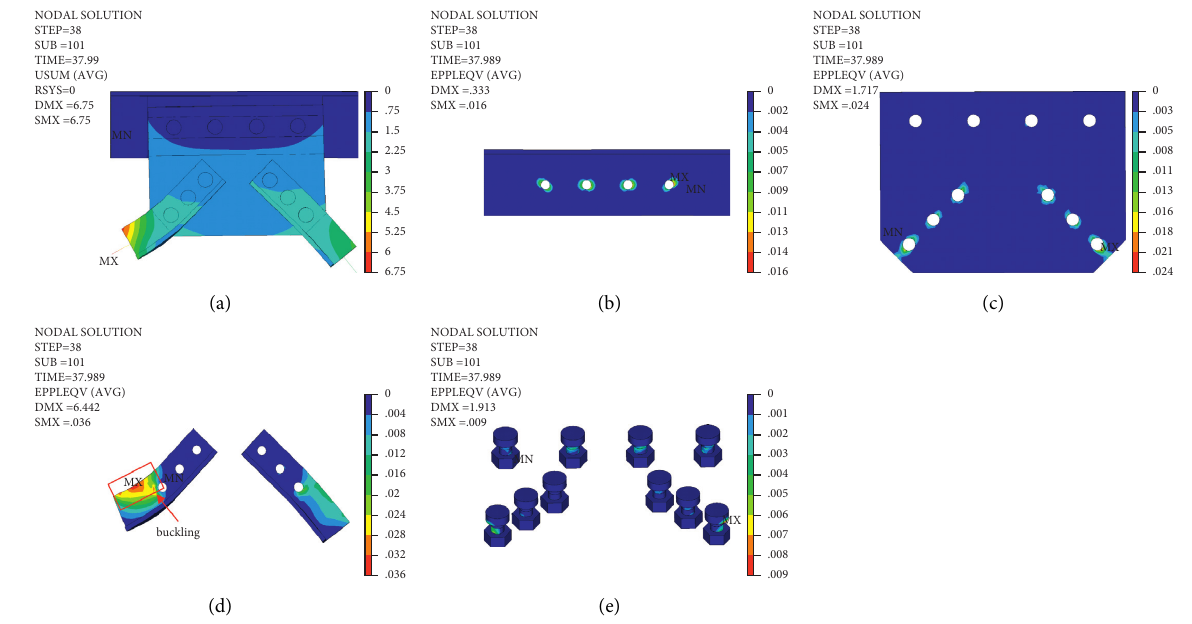
Figure 9: Simulation results for Case 9. (a) Displacement of joint. (b) Plastic strain of main angle steel. (c) Plastic strain of gusset plate. (d) Plastic strain of branch angle steel. (e) Plastic strain of bolts.